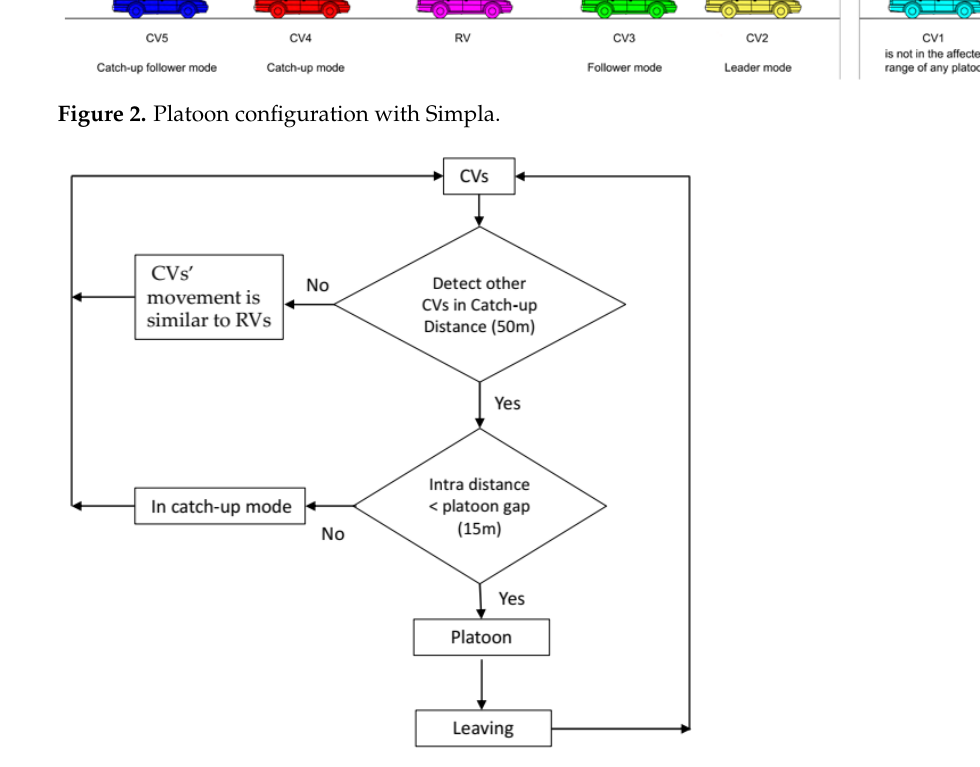
Figure 3. Platooning operation. Table 1. Attributes of platoons.